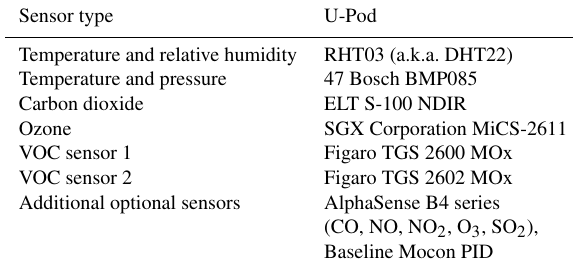
Table 2. Complete list of sensors used in the U-Pod.